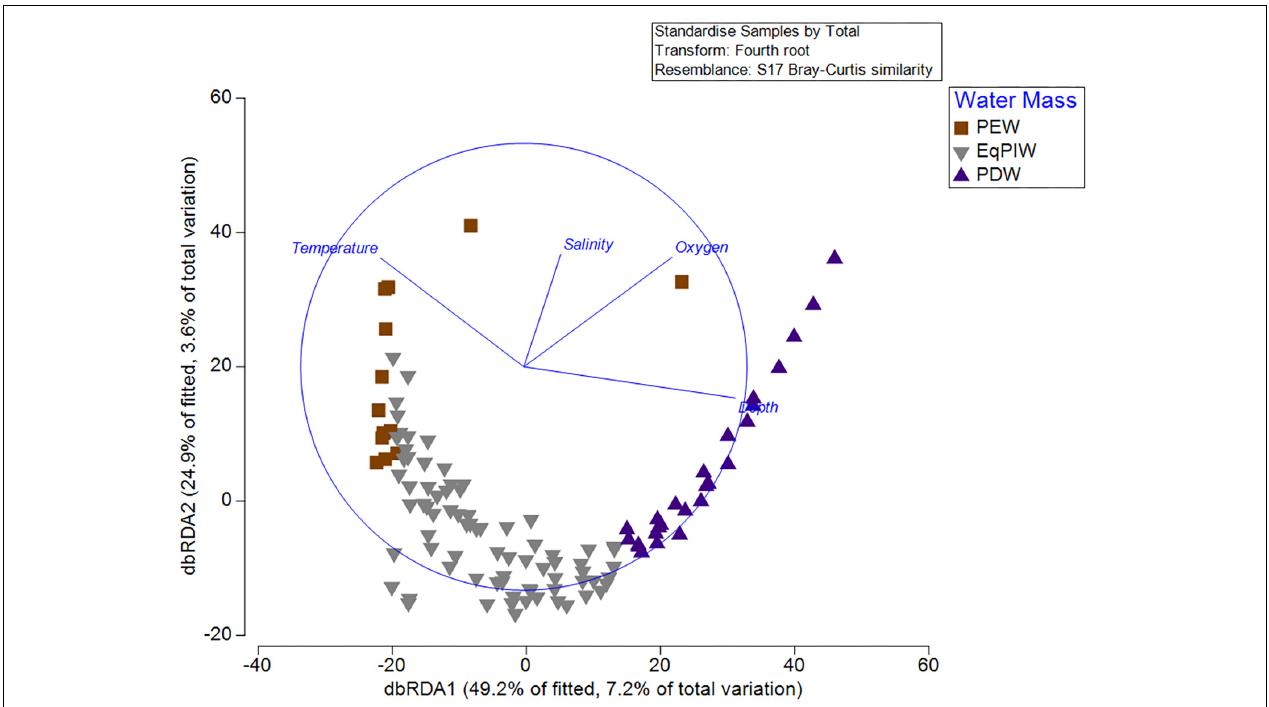
FIGURE 9 | Distance-based redundancy analysis (dbRDA) from standardized and 4th root-transformed species abundances and normalized depth, temperature, salinity, and dissolved oxygen variables. DistLM circle is superimposed in blue with depth, temperature, salinity, and dissolved oxygen vectors. Symbol color and shape denote overlying water mass for each